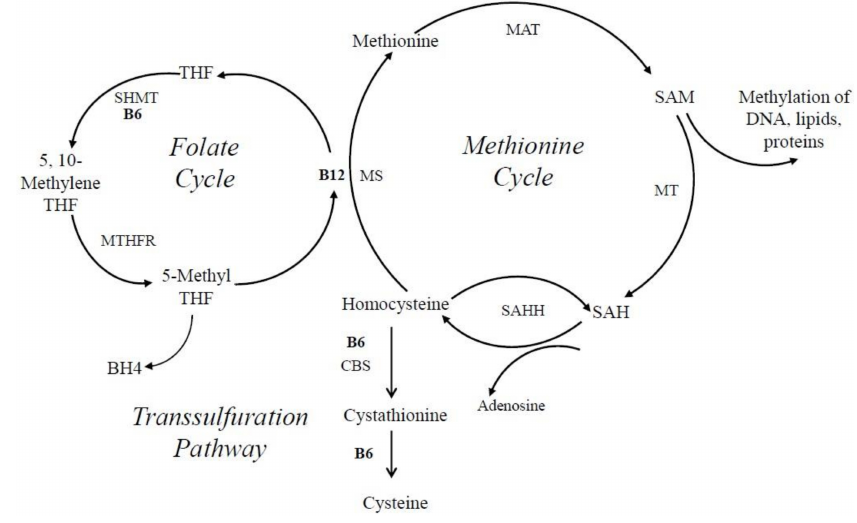
Figure 6. Schematic drawing of the 1-carbon methylation cycle. The methionine